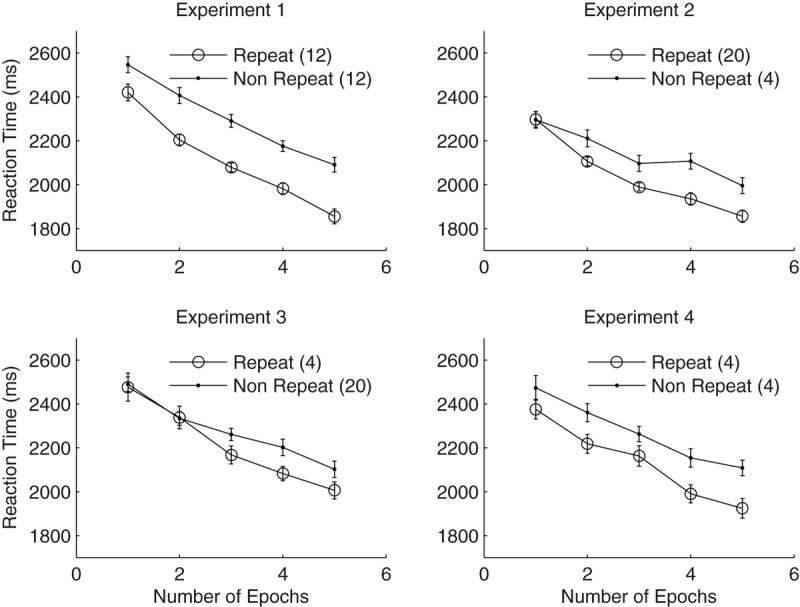
Search Performances as a function of epochs in three experiments. Lines with circles depict the mean RTs for repeated displays, whereas the lines with dots denote non-repeated displays.